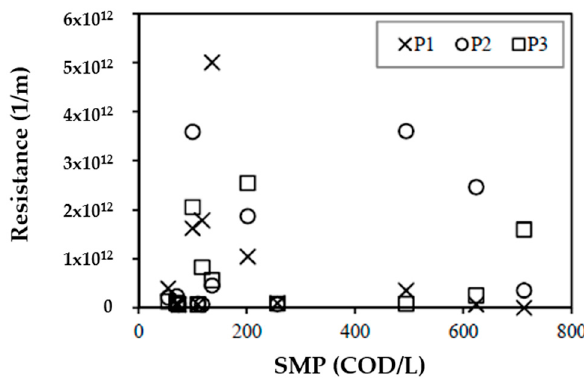
Figure 7. SMP concentration vs. resistance.